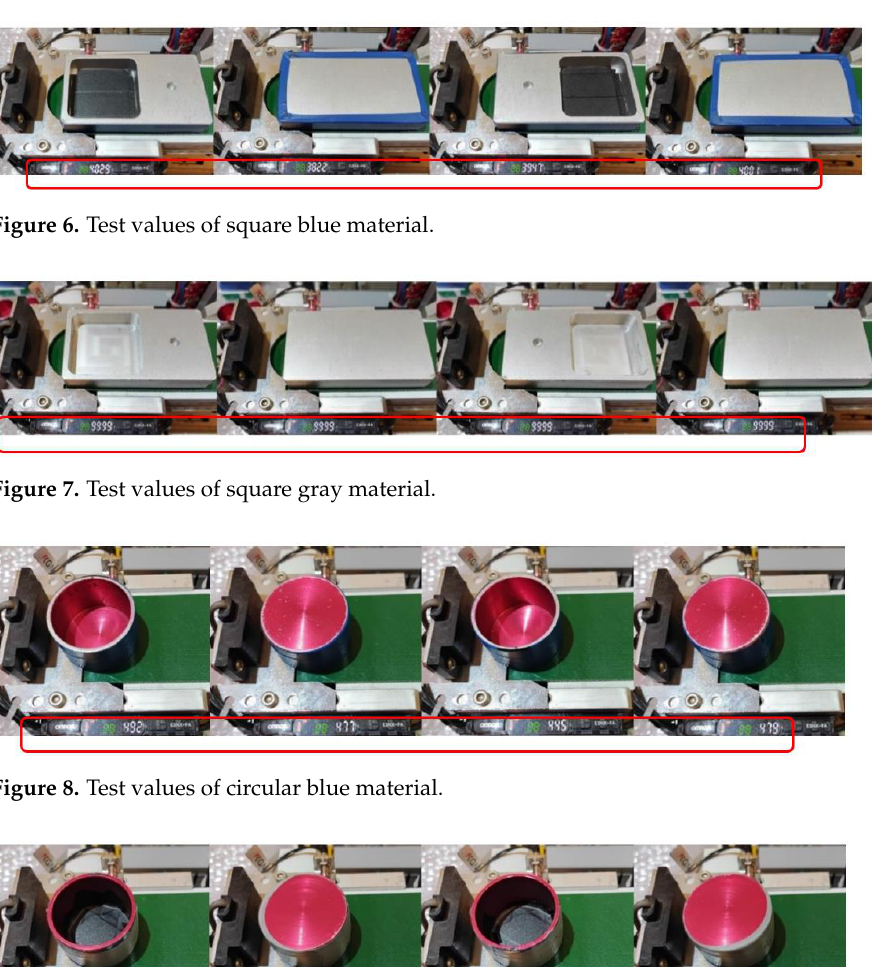
Figure 5. Cyber factory scene.